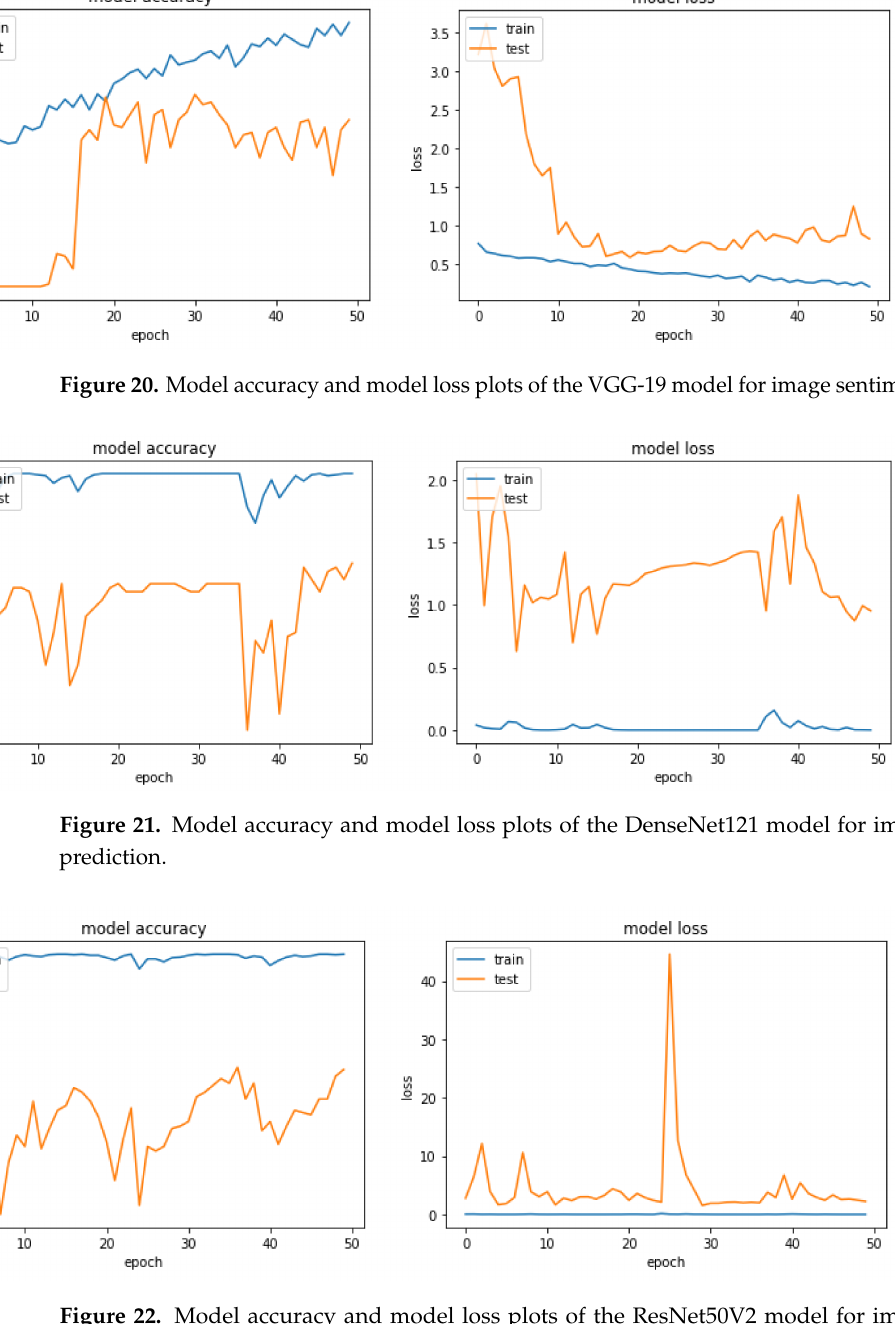
Figure 22. Model accuracy and model loss plots of the ResNet50V2 model for image sentiment